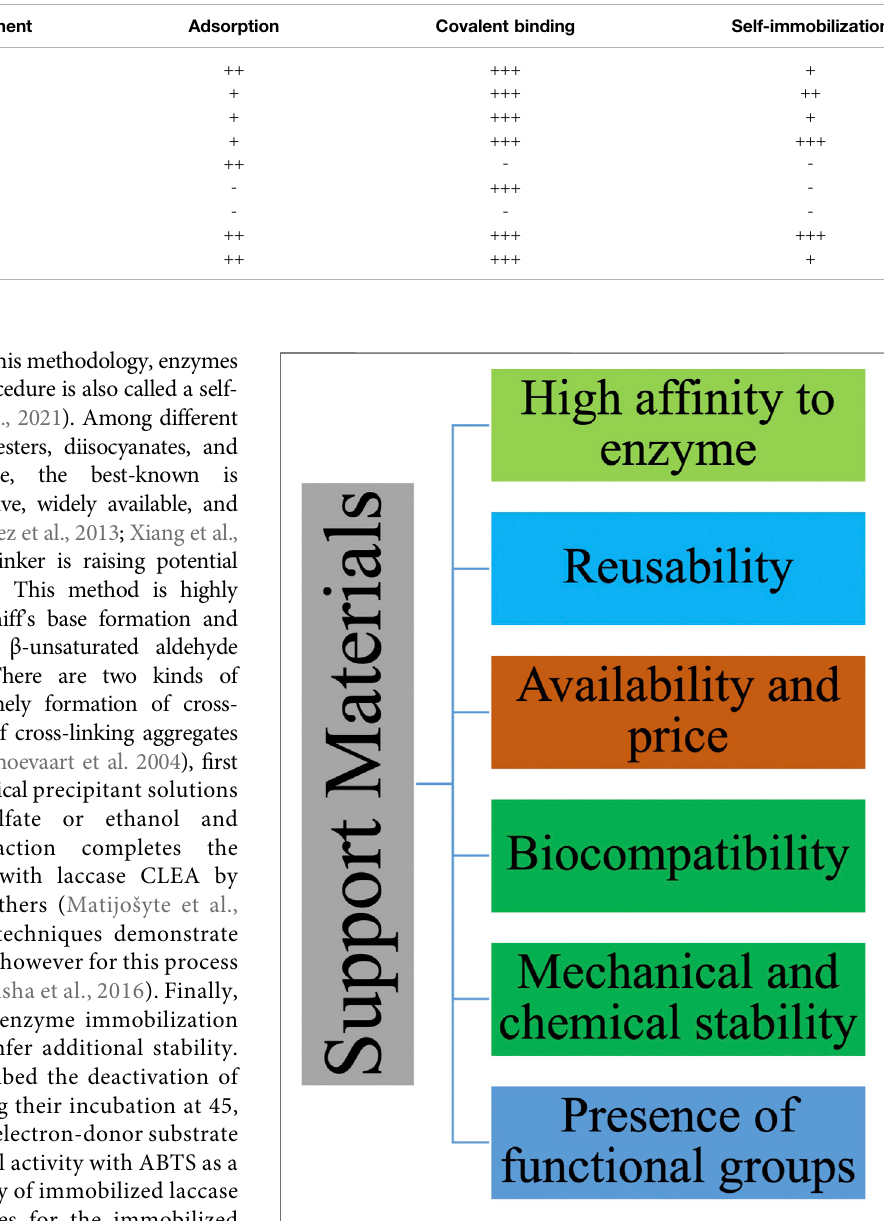
FIGURE 5 | Support properties for laccase